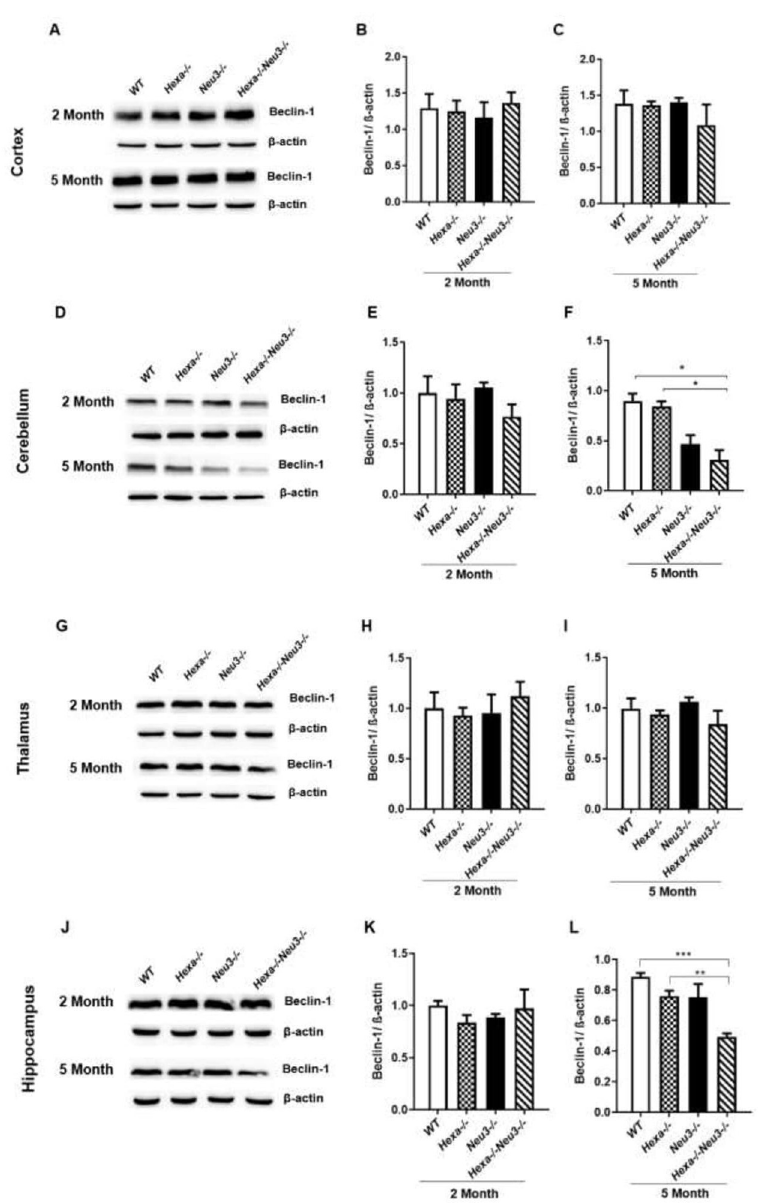
Fig 2. Immunoblot images and densitometric analysis of anti-Beclin-1 in the cortex (A-C), cerebellum (D-F), thalamus (G-I), and hippocampus (J-L) of 2- and 5-month-old WT , Hexa-/- , Neu3-/- , Hexa-/-Neu3-/- mice. β -actin was an internal control. Band intensities were determined by ImageJ and p values were determined by One-way- ANOVA analysis by GraphPad. Data are reported as mean ± SEM (n = 3; � p < 0,05, �� p < 0,025, ��� p < 0,01). cerebellum (Fig 3D) and hippocampus (Fig 3H) but not in the cortex (Fig 3B) and thalamus (Fig 3F) of 5-month-old Hexa-/-Neu3-/- mice compared to WT . Compared to WT and Hexa-/- mice, we showed significantly elevated protein levels of autophagosome-related marker LC3 in all brain regions studied in 5-month-old Hexa-/-Neu3-/- mice (Figs 4C, 4F, 4I, and 4L). Although we found notably increased LC3 protein levels in the cortex (Fig 4B) and cerebellum (Fig 4E) regions of 2-month-old Hexa-/-Neu3-/- mice compared to WT and